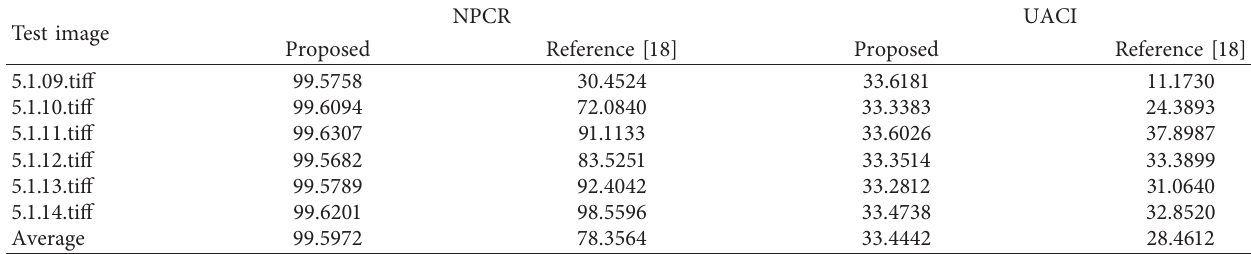
Table 11: Differential attack analysis (%).